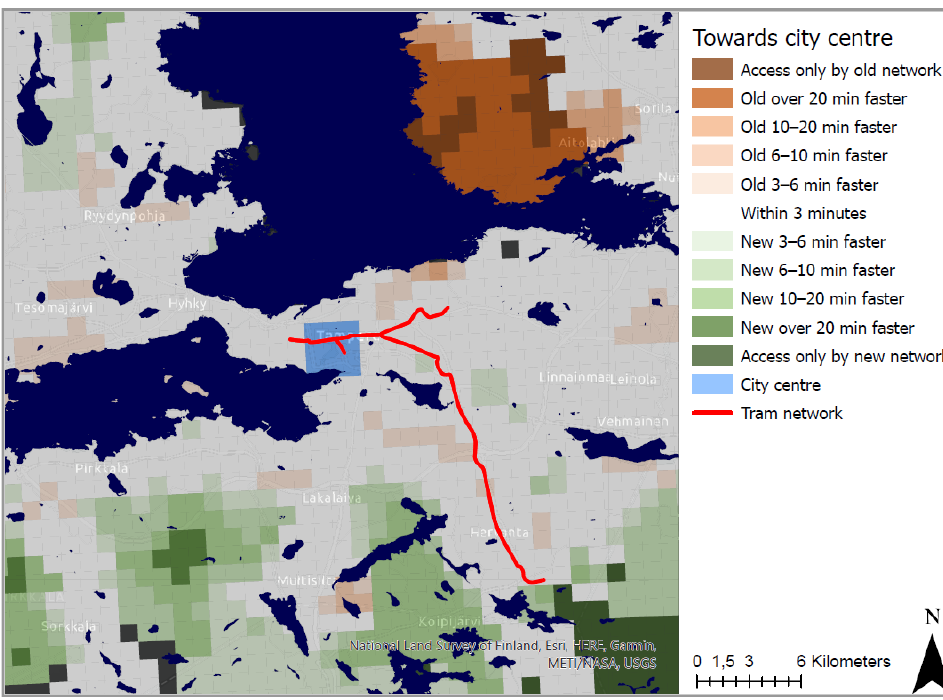
Figure 4. Difference on time taken to reach the city centre in Tampere, Finland.